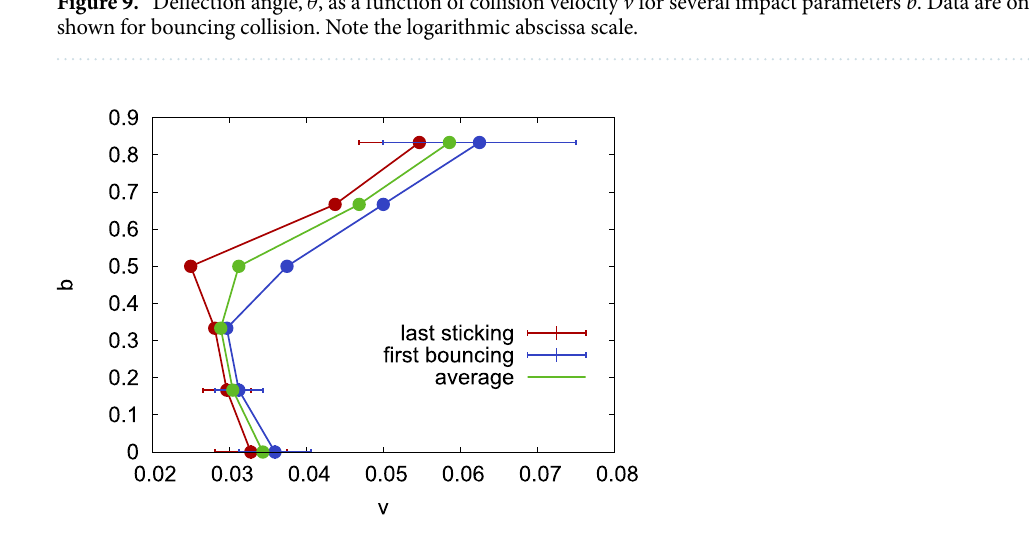
0 , 0.17 and 0.83 are taken from =